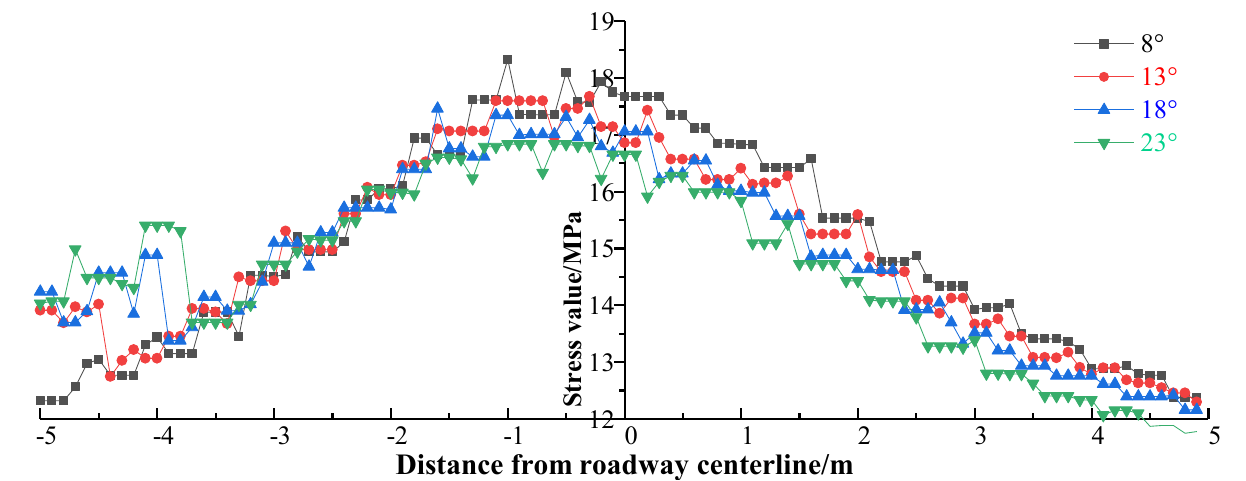
Figure 15. Line chart of X -axis stress of the roadway floor.